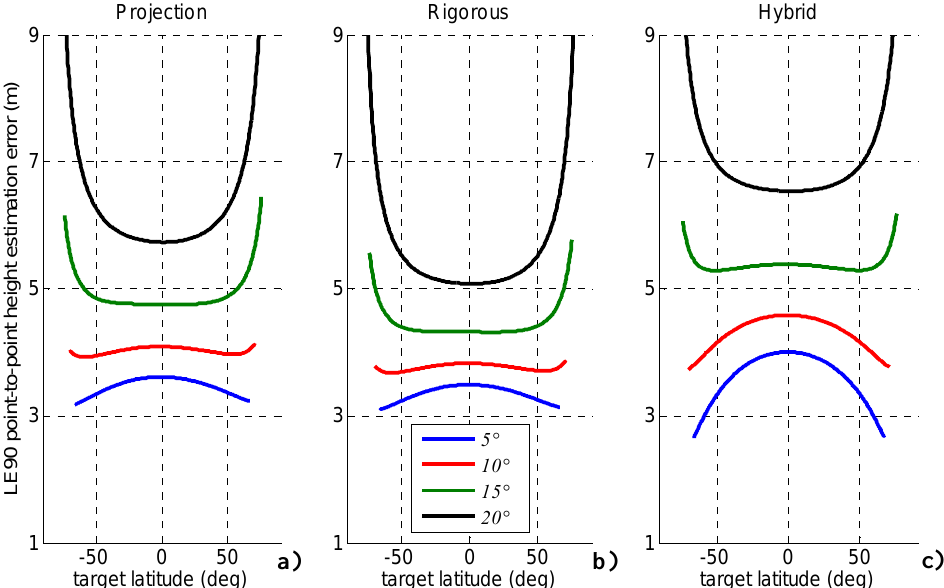
Figure 12. Performance comparison between the analyzed methods for spaceborne bistatic SAR stereo radargrammetry considering 1/10 of an image pixel as co-registration uncertainty and four bistatic off-nadir angles: (a) projection of bistatic parameters, (b) bistatic rigorous stereo SAR problem, (c) hybrid